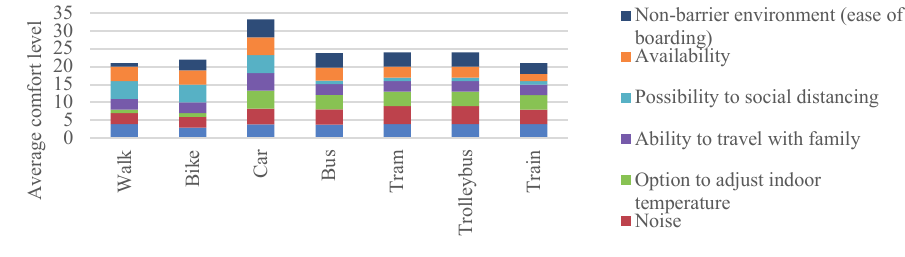
Fig. 5. Assessment of the level of comfort of types of transportation.